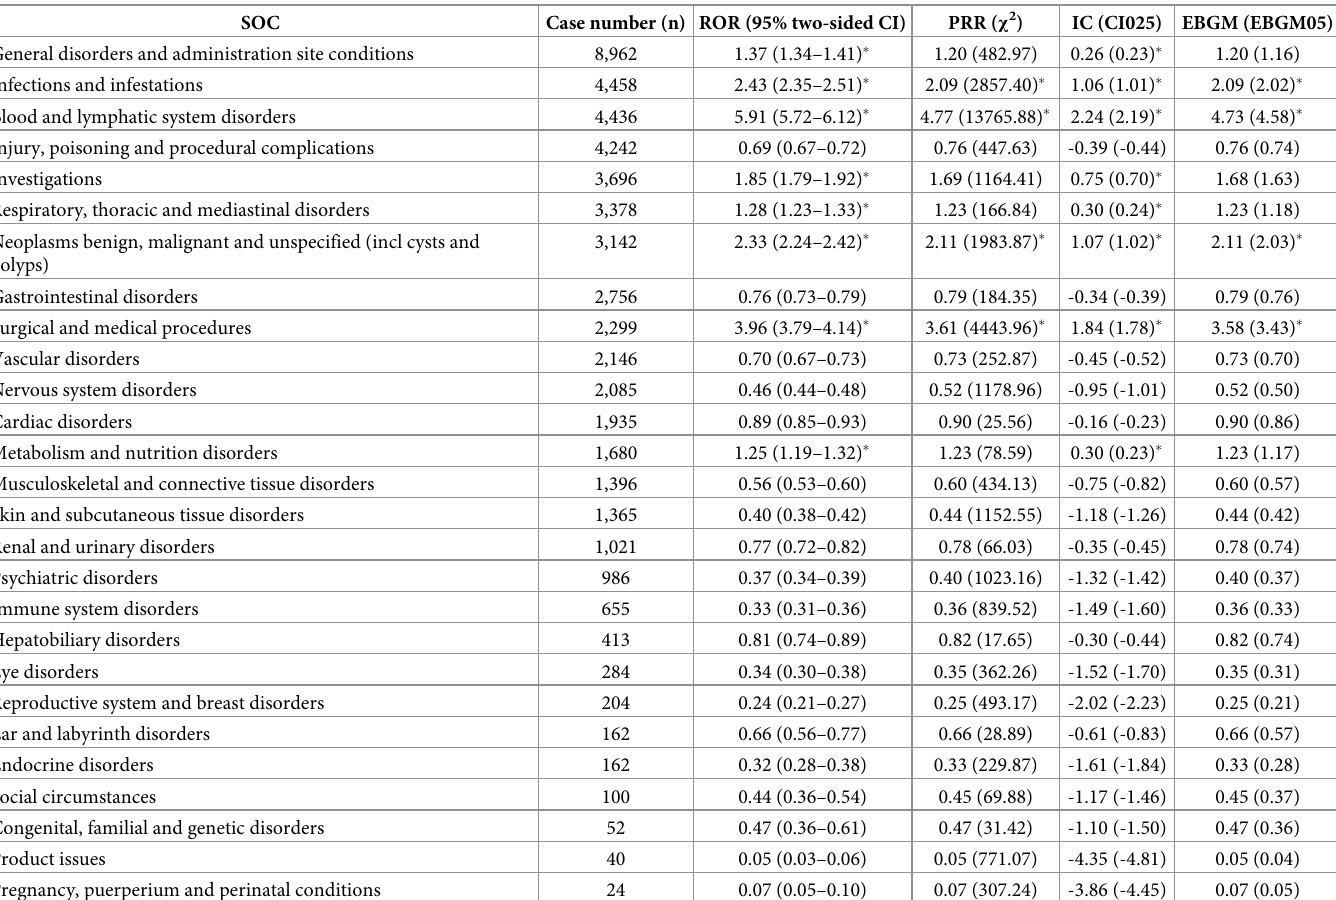
Table 2. Signal values of reports associated with venetoclax at the SOC